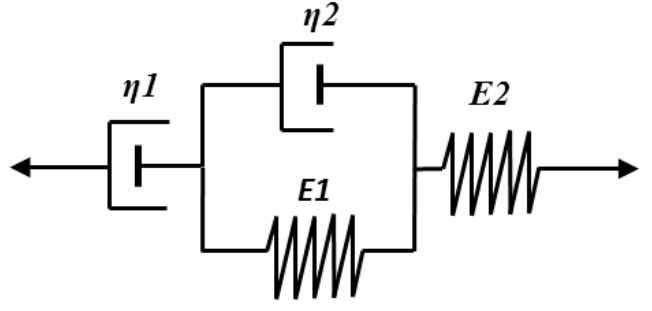
Figure 3. Schematic image of the Burgers model.